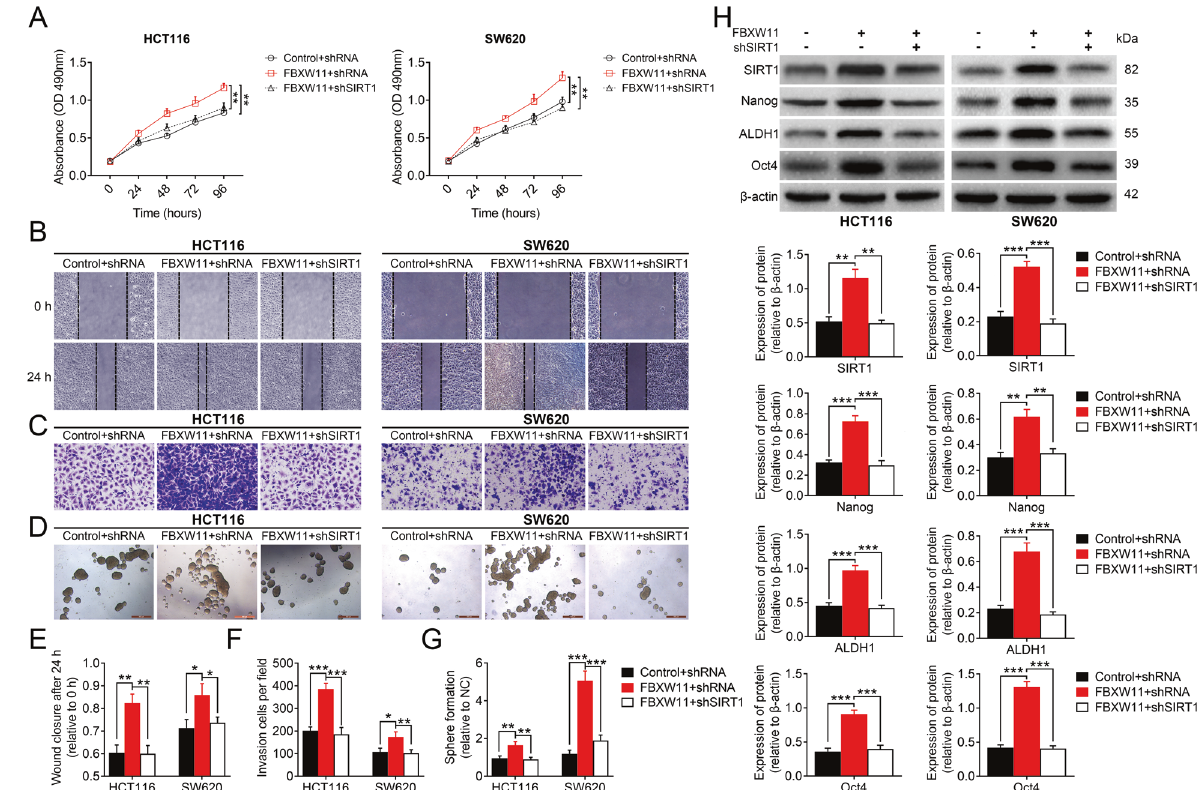
Fig. 6 FBXW11 mediates stem-cell-like properties of CRC cells via SIRT1. HCT116 and SW620 cells were co-transfected with recombinant lentiviral vectors carrying FBXW11 (or empty control vectors) and shRNA targeting SIRT1 (or scrambled shRNA sequence). A Cell viability at different time points after transfection was evaluated by the MTT assay. B , E The wound-healing assay was used to assess the migration capacity of CRC cells following transfection. The wound closure at 24 h after scratching was measured. C , F The invasion capacity of transfected CEC cells was determined by the Transwell assay. The number of invaded cells per fi eld at 24 h post plating was calculated. D , G The sphere-forming ability of CRC cells following transfection was evaluated by the sphere formation assay. The number of spheres with a diameter of over 50 μ m was counted. H The protein expressions of Nanog, ALDH1, and Oct4 were assessed by western blotting. ANOVA followed by Bonferroni ’ s post hoc test was used for statistical comparisons among multiple